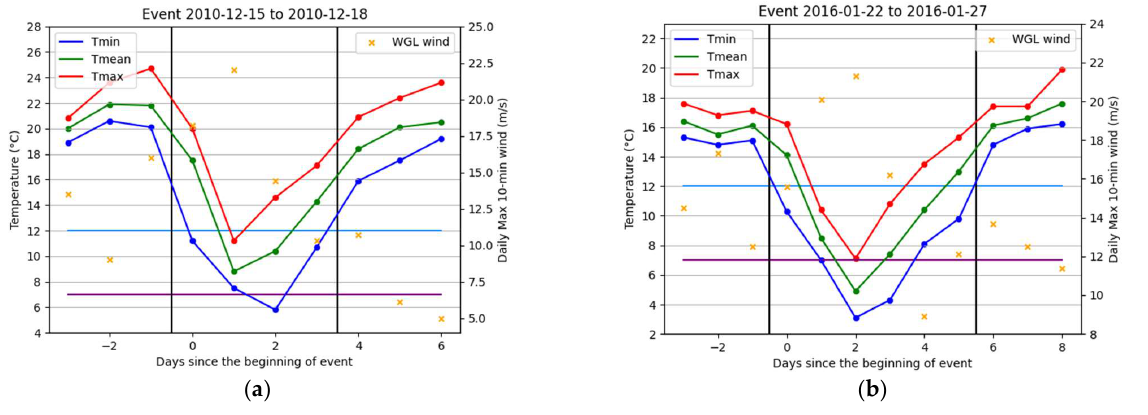
Figure 8. Two cases classified as “extreme cold surge”: ( a ) time series of the cold event on 15–18 December 2010 and ( b ) the other on 22–27 January 2016. The start day of each event was labelled as Day 0. The daily (local time) minimum, mean and maximum temperatures were represented in blue, green and red dots, respectively. The daily maximum 10-min wind records at Waglan Island were marked as orange crosses. The horizontal light blue and purple lines indicate the thresholds for “cold” (12.0 °C) and “very cold” (7.0 °C) days, and the two black vertical lines confine all data points within the event for easy appreciation. For the two cases, ( T , ∆ T , w ) were ( a ) (5.8 ◦ C, − 12.6 ◦ C, 22.0 m/s) and ( b ) (3.1 ◦ C, − 8.1 ◦ C, 21.3 m/s),